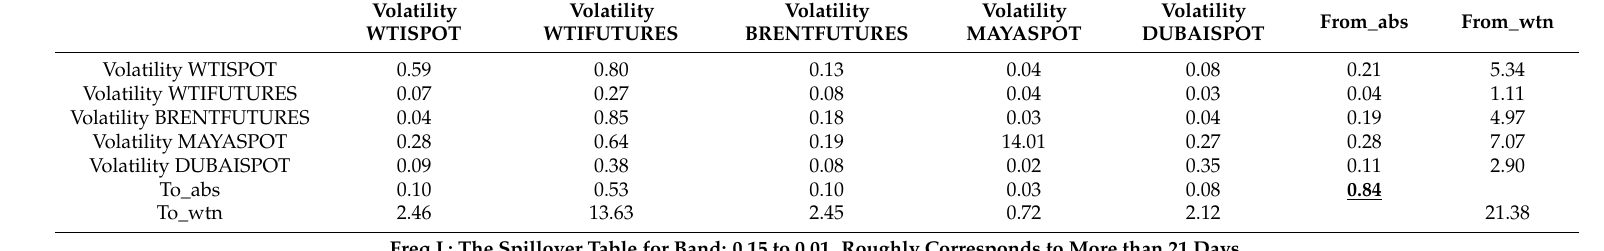
Freq L: The Spillover Table for Band: 0.15 to 0.01. Roughly Corresponds to More than 21